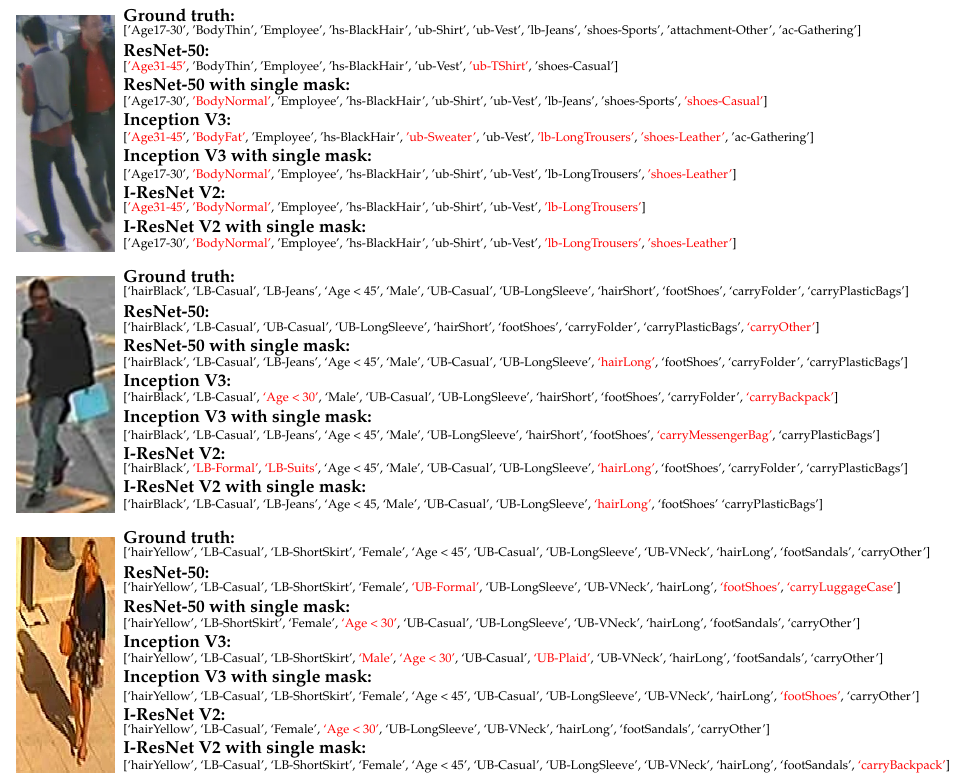
Figure 9. The examples of the predicted attribute on pedestrian images with normal circumstance with various race, where the wrong attributes are presented as red characters.